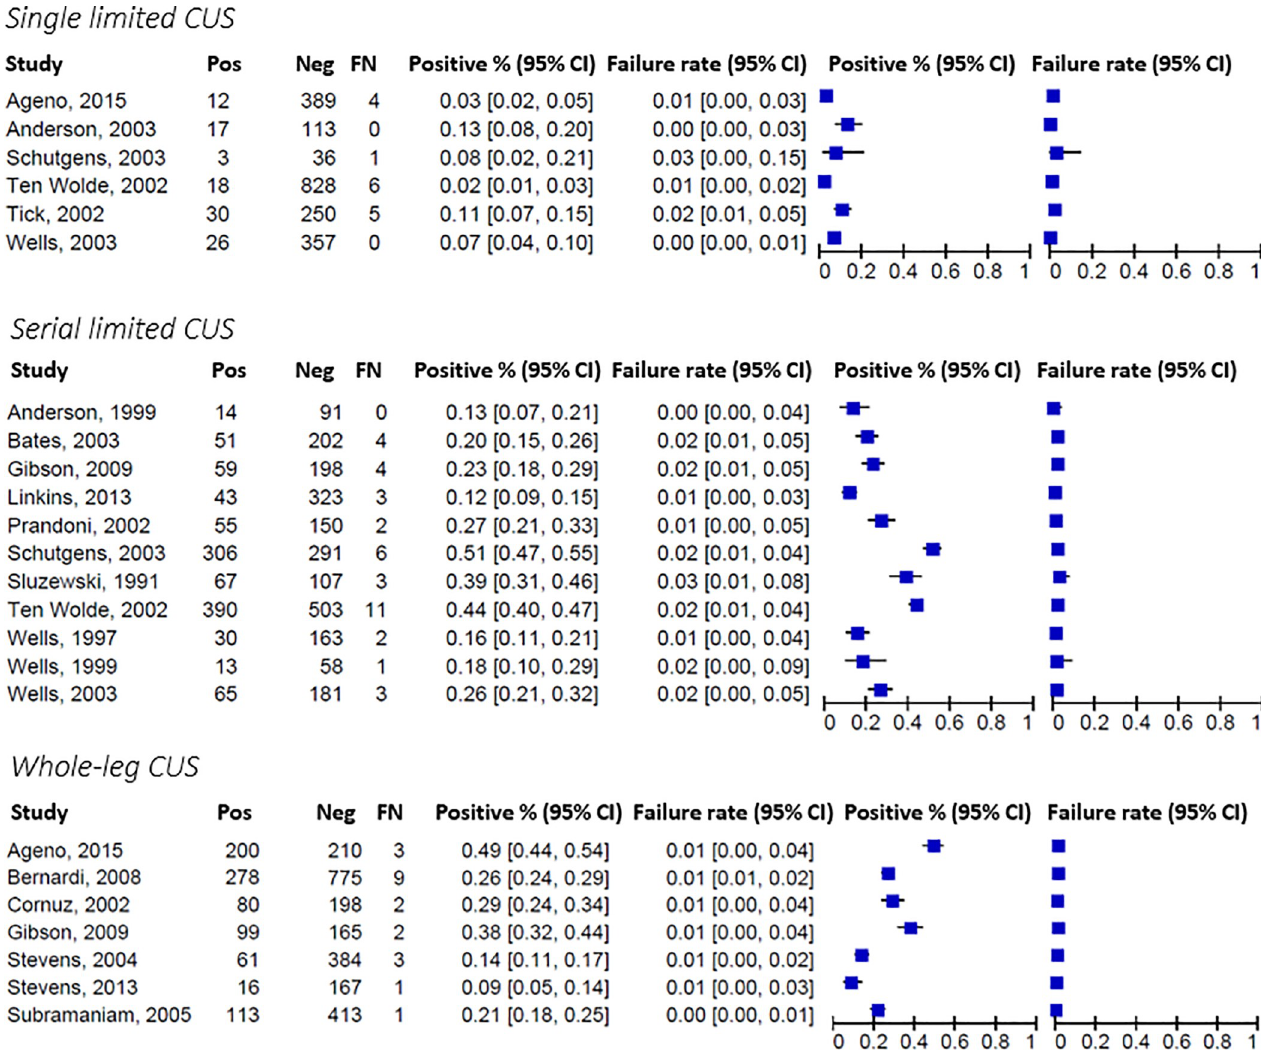
Fig 2. Forest plots diagnostic accuracy of compression ultrasonography in studies that used clinical follow-up as a reference standard. Abbreviations: CI: confidence interval, CUS: compression ultrasonography. Pos and Neg indicate the number of positive and negative CUS results; FN (false negative) indicates the number of venous thromboembolic events during follow-up in those with a negative CUS result.